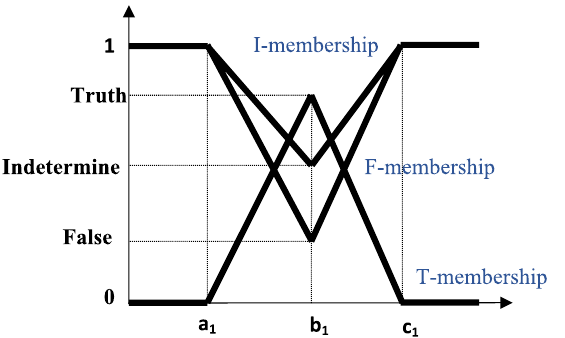
Figure 1. A standard single valued triangular neutrosophic number 38